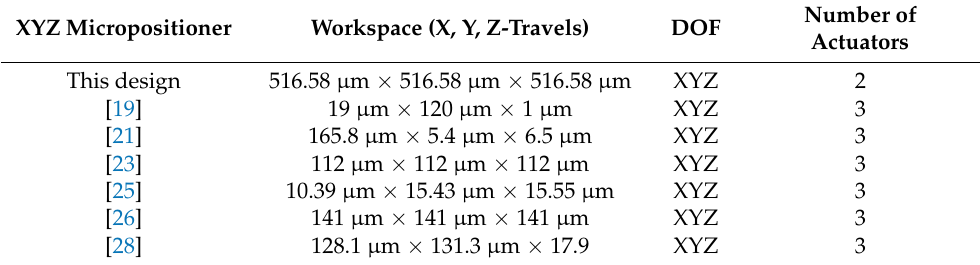
Table 9. Comparison of the workspace of proposed XYZ micropositioner with the previously existing XYZ micropositioning